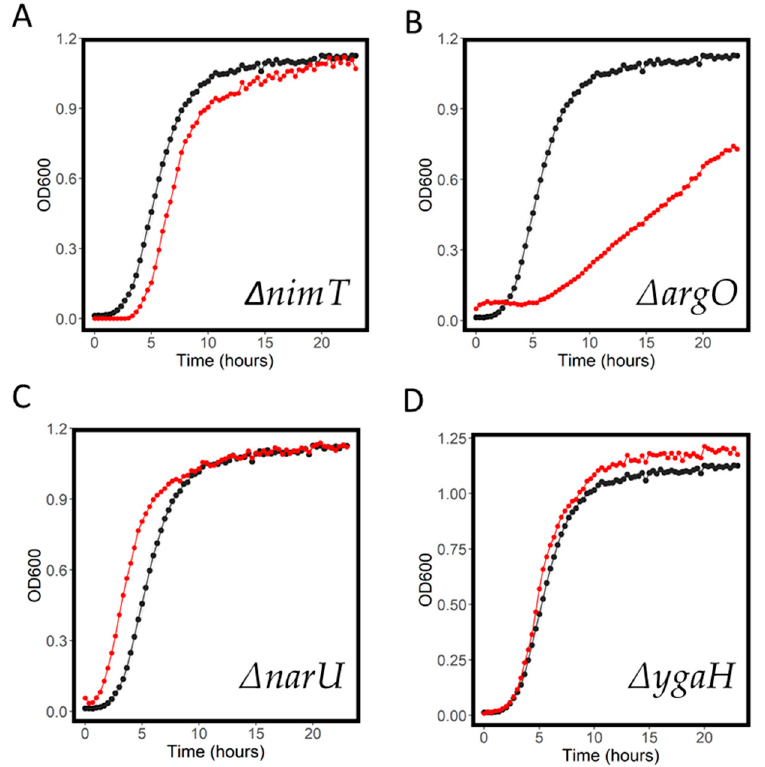
Figure 5. Growth curves for WT (black) and knockout strains (red) in 400 mg/L ornidazole. ∆ nimT ( A ), ∆ argO ( B ), ∆ narU ( C ) and ∆ ygaH ( D ) are shown. Shaded areas represent the standard deviation for the WT growth curve. Table 2. Growth parameters for the 15 most sensitive and most resistant strains in Ornidazole by normalized AUC. Normalized values show the value in ornidazole/value in LB for the given strain.